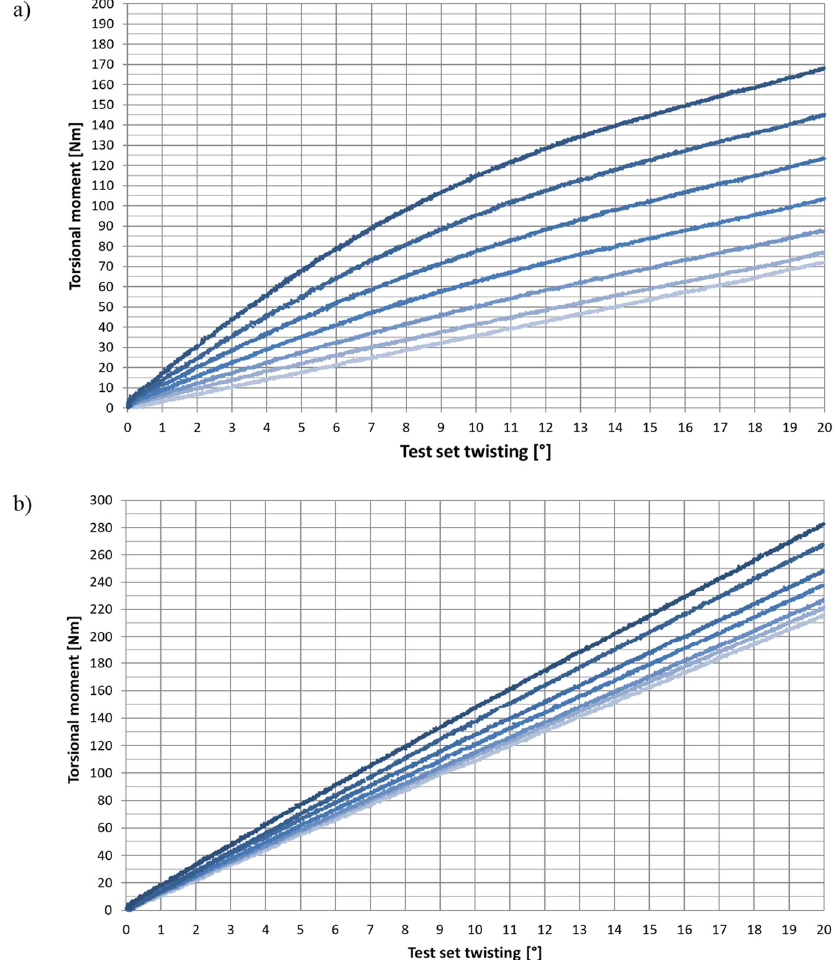
Figure 7. Experiment. Torsional moment (torque) change depending on the test set torsion. The following expansions are marked with colors, from the lightest to the darkest: 0, 5, 10, 15, 20, 25 and 30 mm. ( a ) 3 × 60 package ( b ) 6 × 30 package.